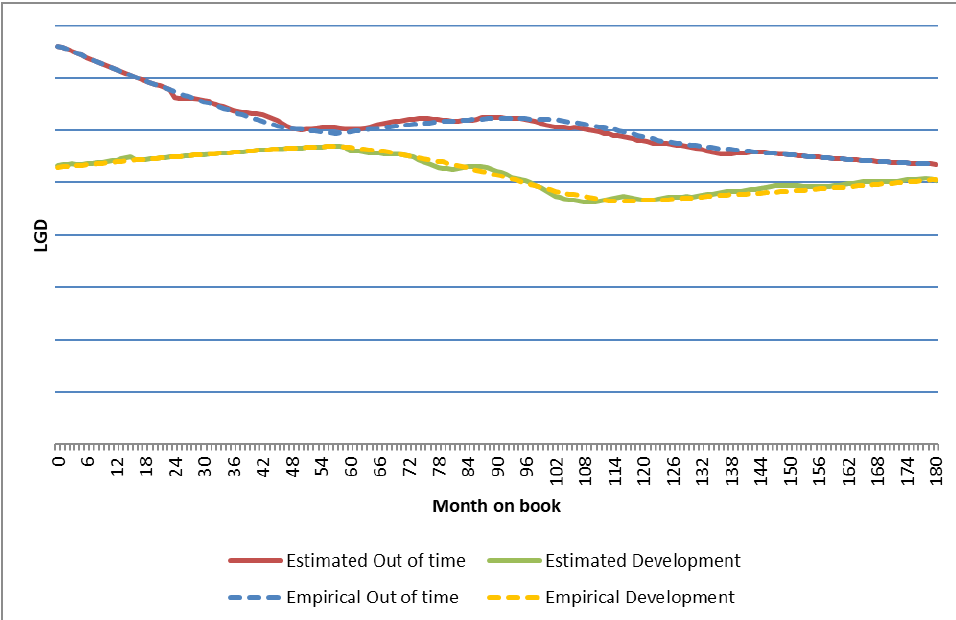
Figure 3. Empirical and estimated IFRS 9 LGD by month on